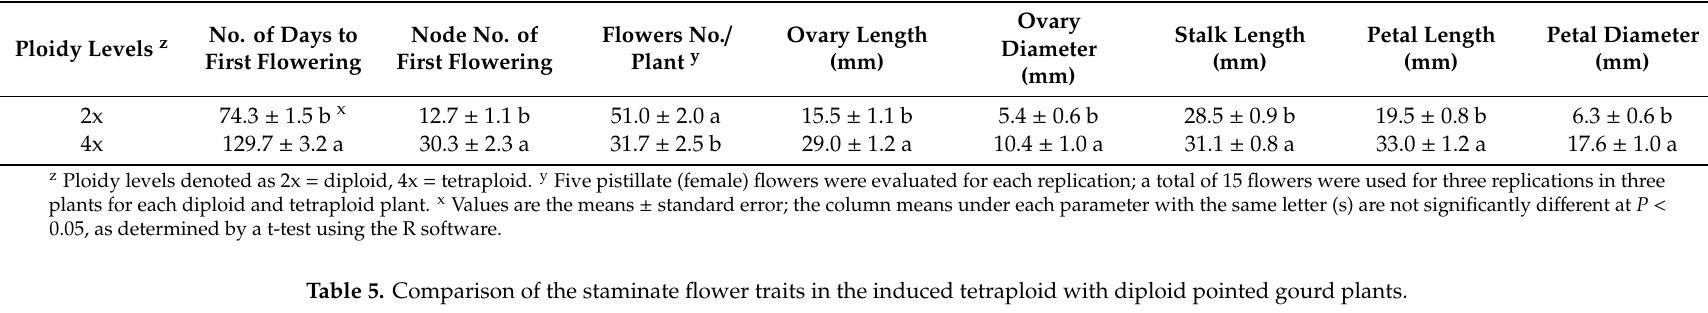
Table 4. Comparison of the pistillate flower traits in induced tetraploids with diploid pointed gourd plants.